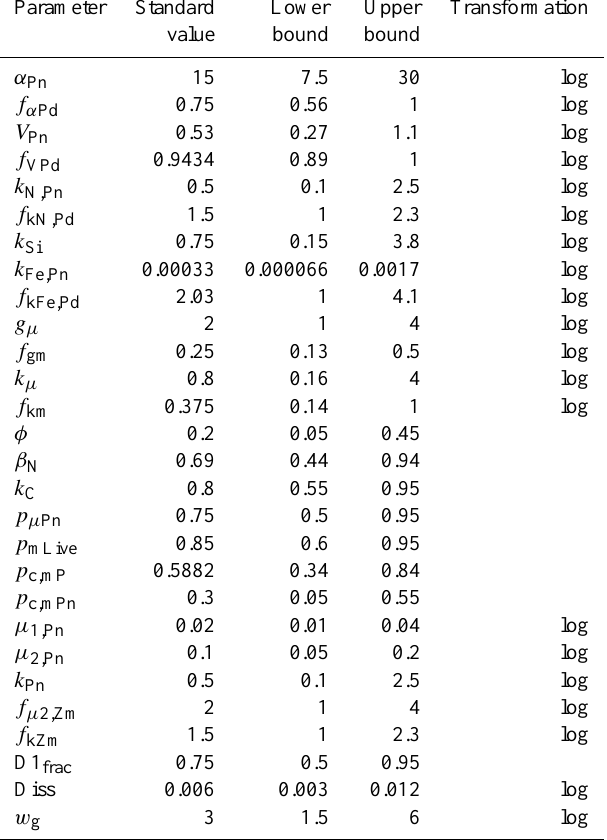
Table A4. MEDUSA parameter space for 28-dimensional sensitiv- ity